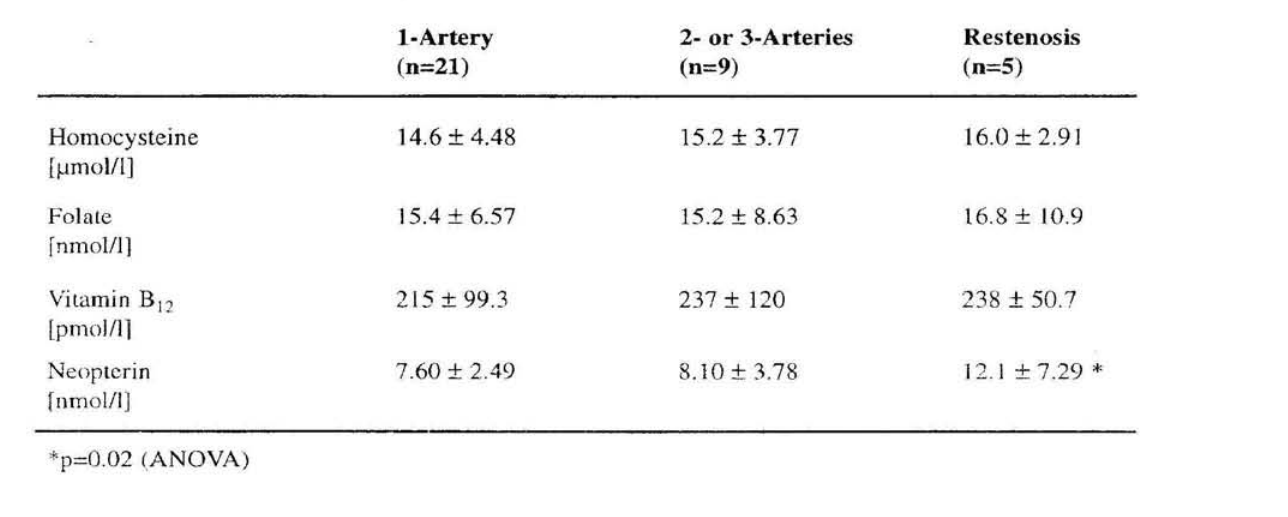
Table 2. Scrum concentrations of homocysteine, folate, vitamin B¡ > and neopterin in patients with coronary